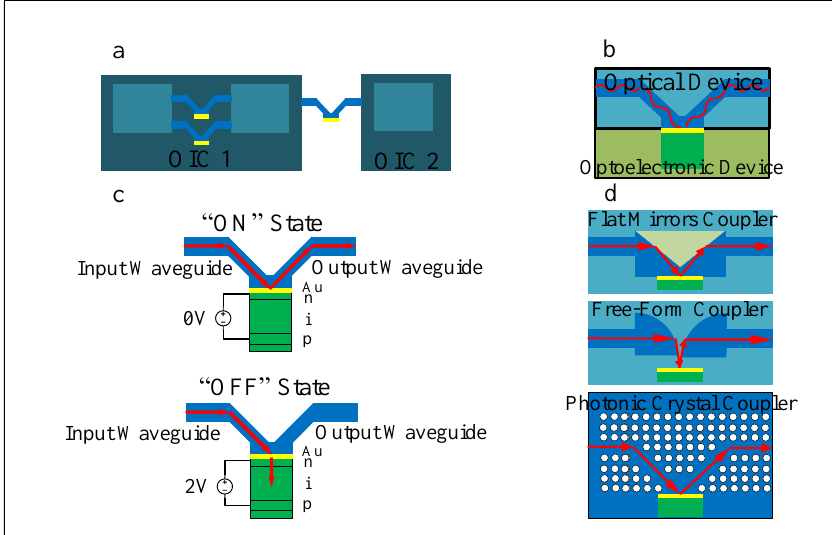
Figure 1. The illustrations are schematics. ( a ) Applications of the electro-reflective modulators in the interconnections of an OIC and the optical connection between two OICs. ( b ) The top section shows the optical component, and the bottom section shows the electronic component of this modulator. ( c ) The operation of the “on” and “off” states of the device is illustrated. ( d ) The optical section of the modulator shows the flat reflector, parabolic reflector, and